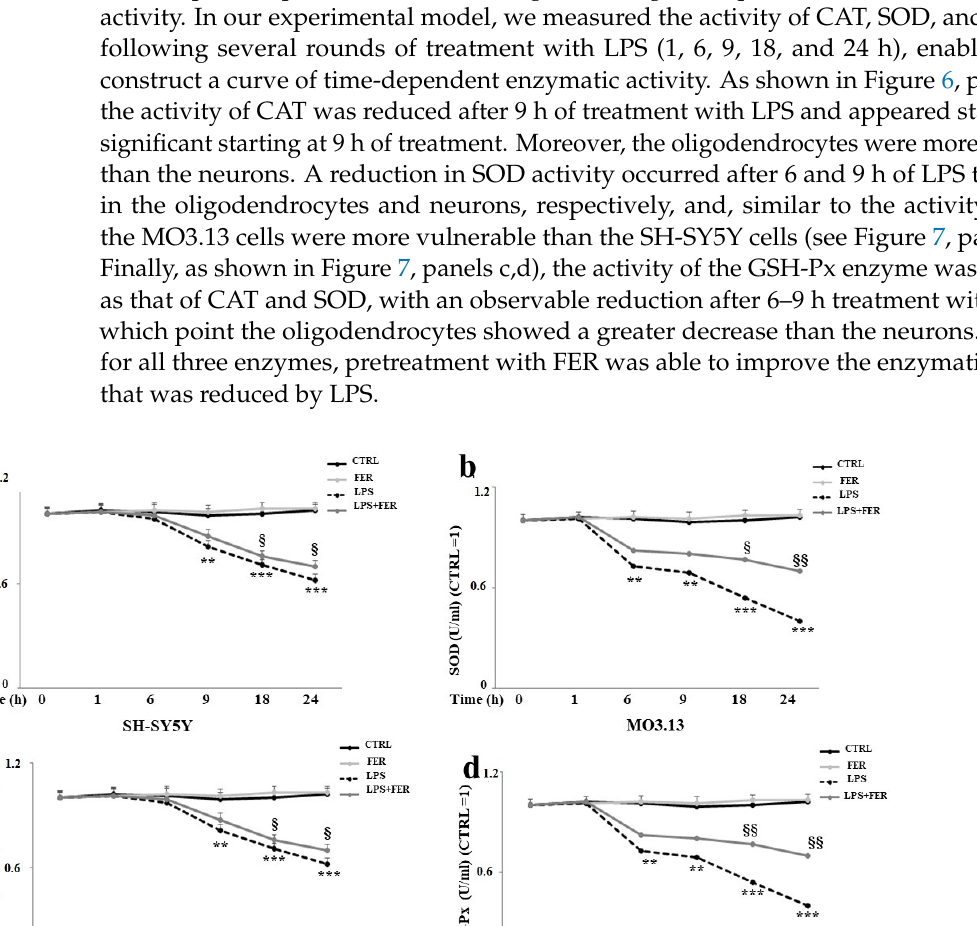
are expressed as the mean ± standard deviation (sd). ** denotes p < 0.01 vs. the control; *** denotes p < 0.001 vs. the control;